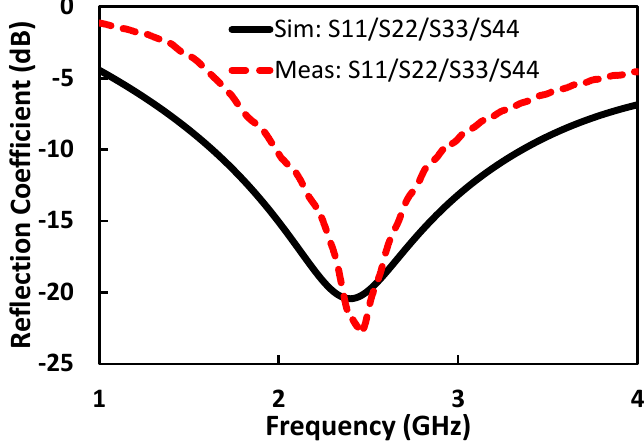
Figure 5. Simulated and measured s-parameters of the proposed MIMO antenna.